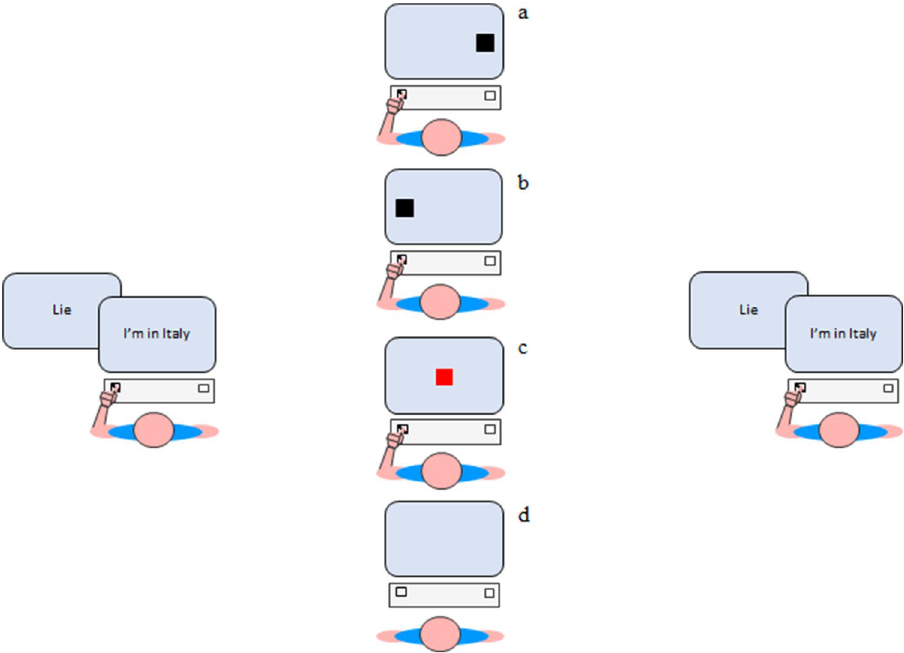
Figure 2. Temporal sequence of a representative trial in the Baseline (leftmost panel) and in the Test sessions (rightmost panel), and during the Training session [middle panel ( a ): incompatible spatial task, condition 1; middle panel ( b ): compatible spatial task, condition 2; middle panel ( c ): non-spatial task, condition 3; middle panel ( d ): no-Training task, condition 4]. Note that stimuli are not drawn to